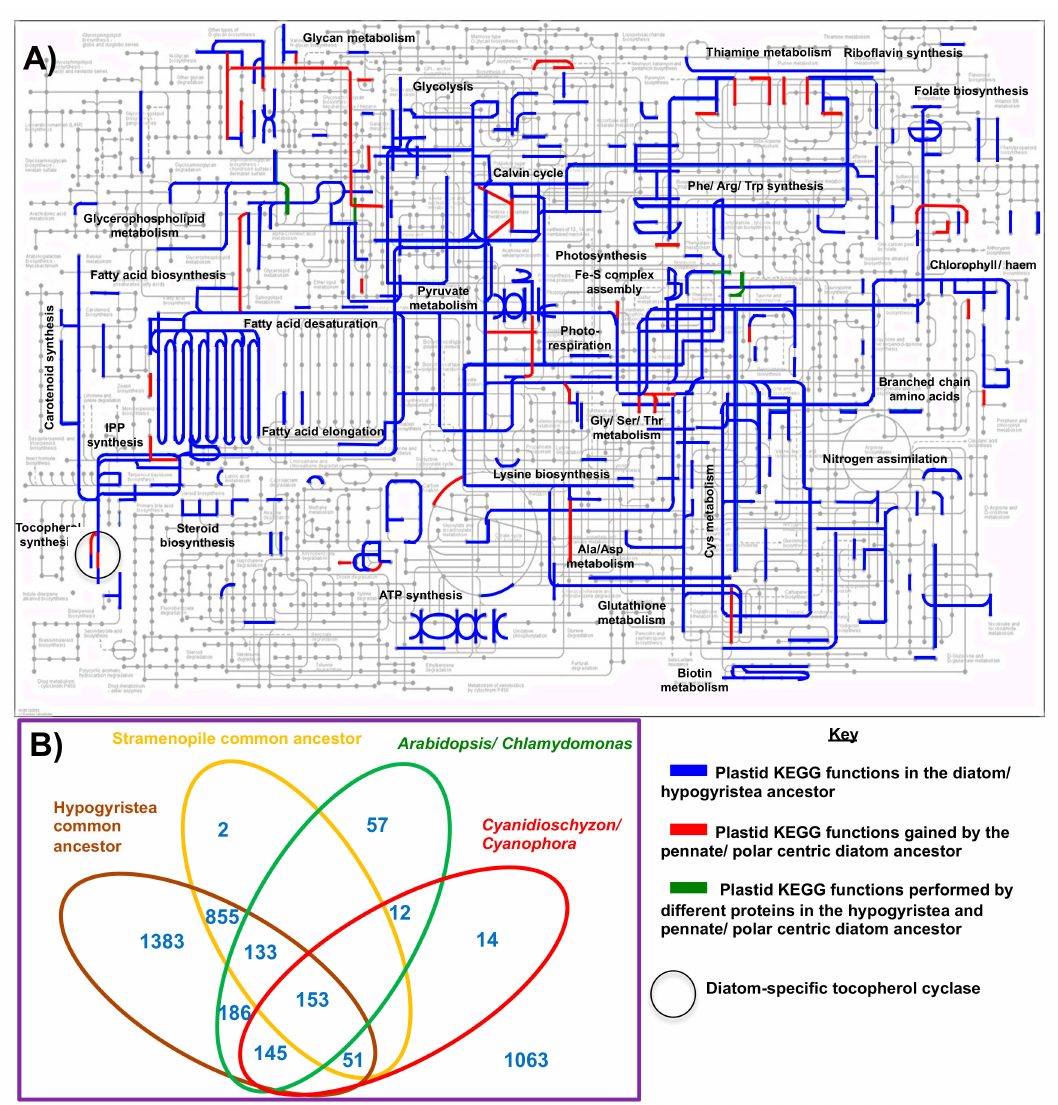
Figure 3. Innovations in metabolic complexity in the diatom chloroplast. Panel ( A ) shows